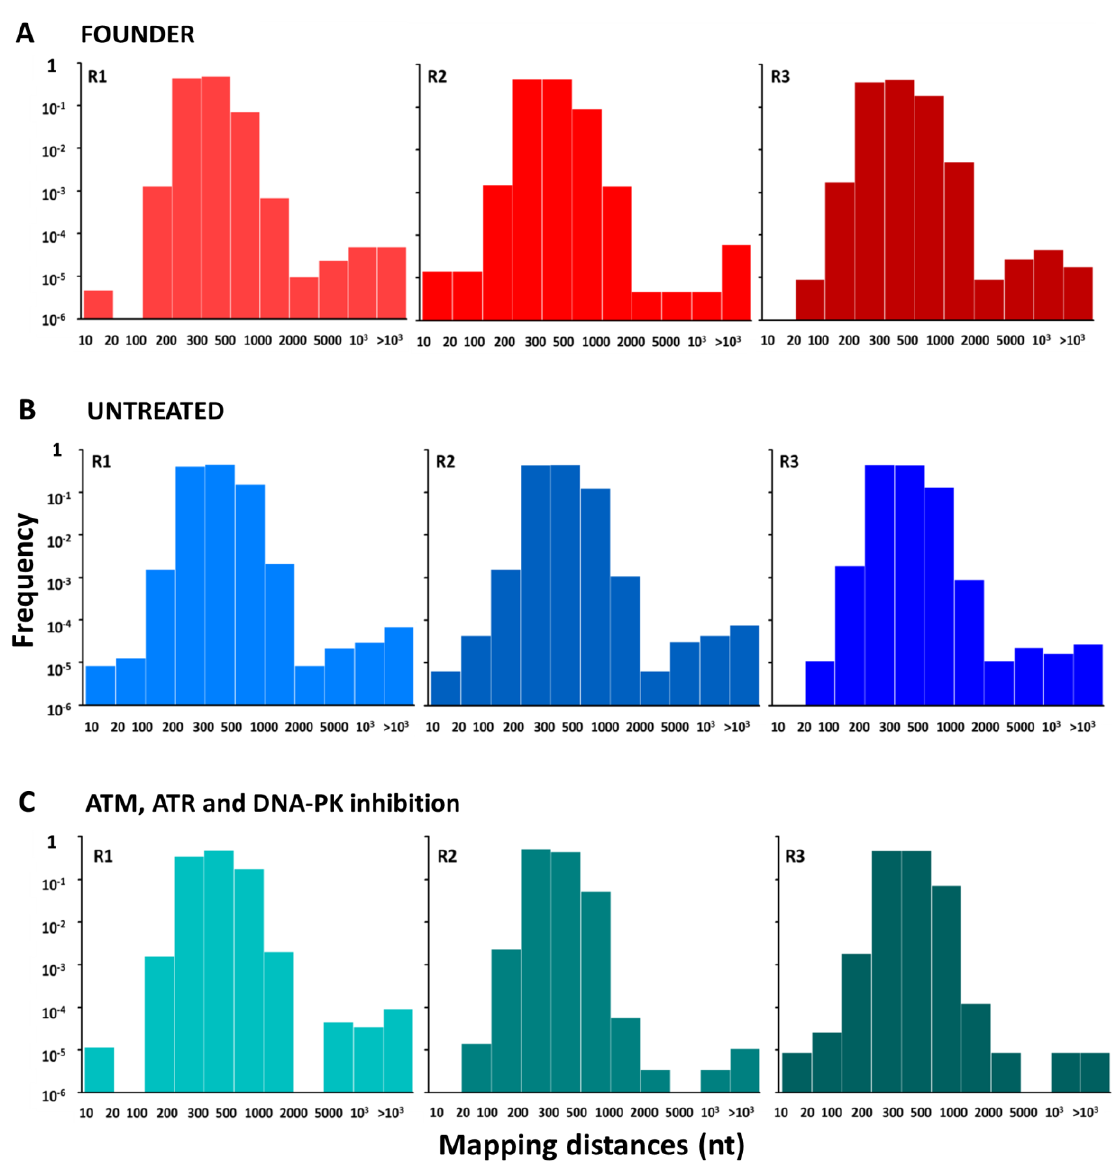
Figure 3. Distribution of deletion sizes for each of the nine sequenced adenovirus populations. The frequency of each gap size between paired-end reads is represented for each replicate of the founder virus ( A ) and each evolved virus population (untreated and DDR kinase triple inhibition) ( B and C ). The frequency of each gap size was calculated by dividing the count of gaps between an established size interval by the total number of gaps or paired-end reads analyzed.